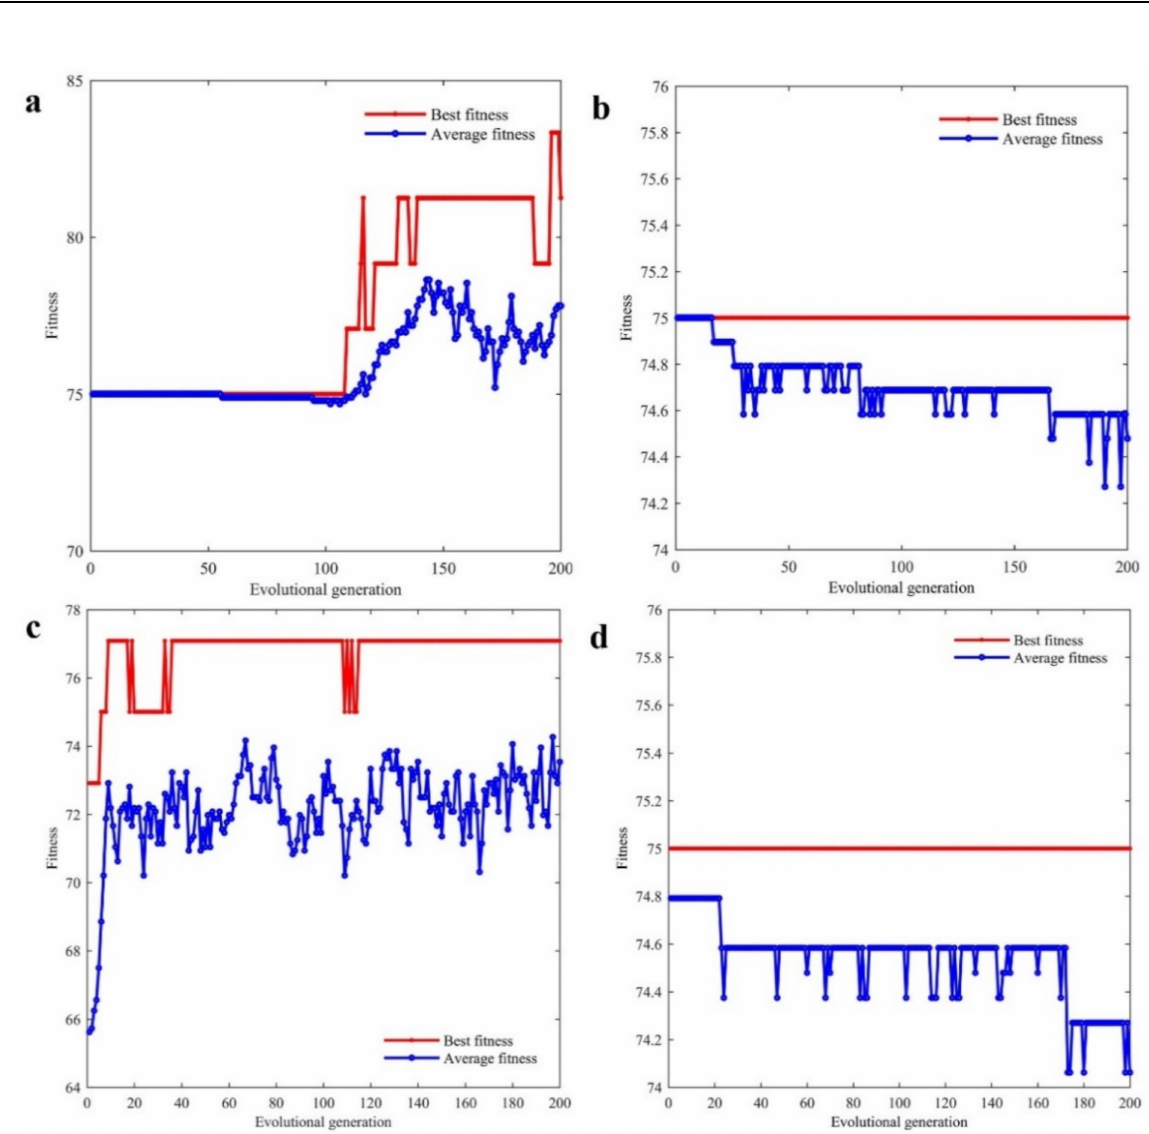
Figure 7. The parameters searching process of GA: ( a ) training dataset 1; ( b ) training dataset 2; ( c ) training dataset 3; ( d ) training dataset